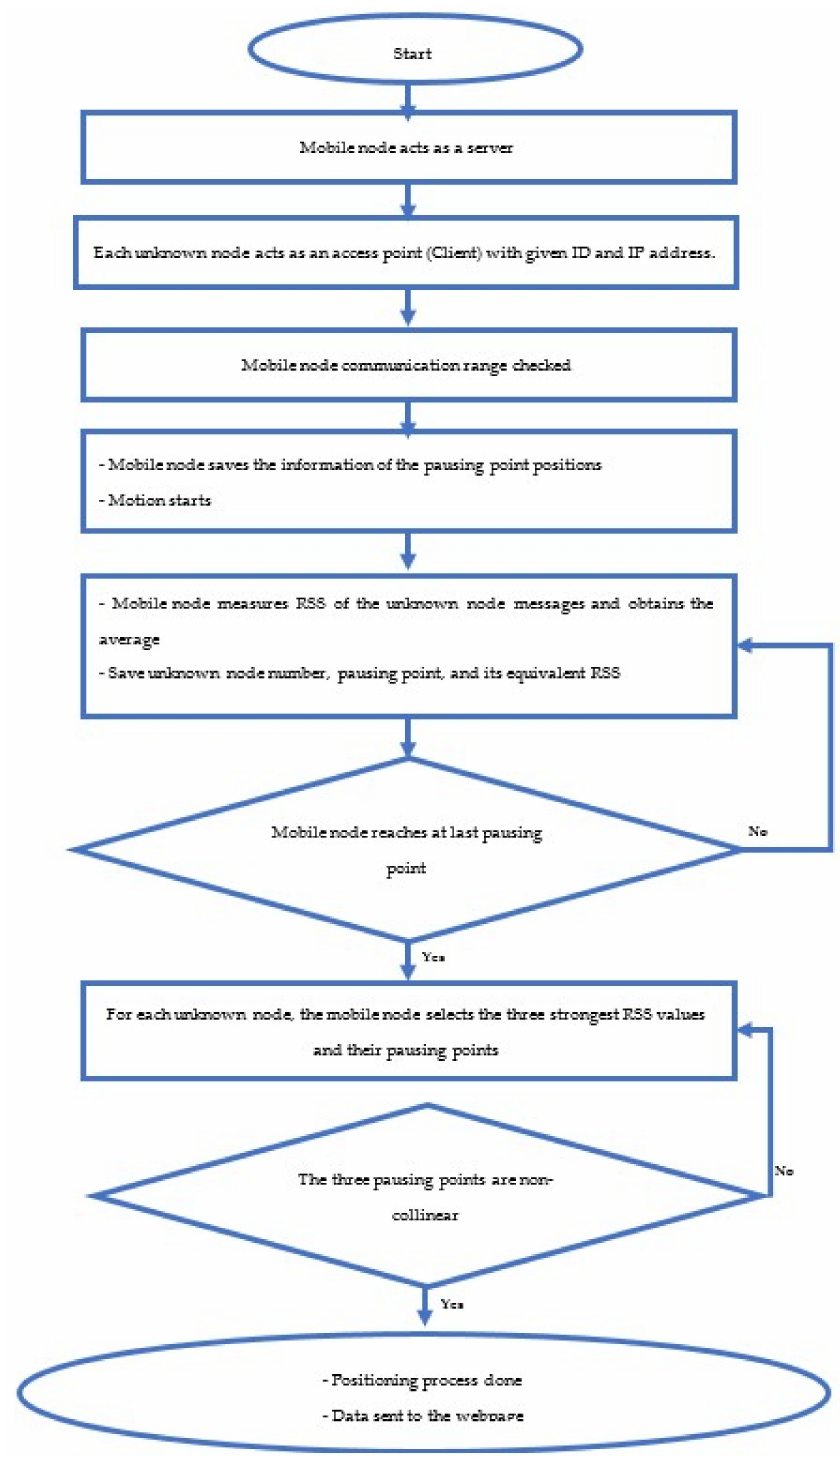
Figure 6. Second